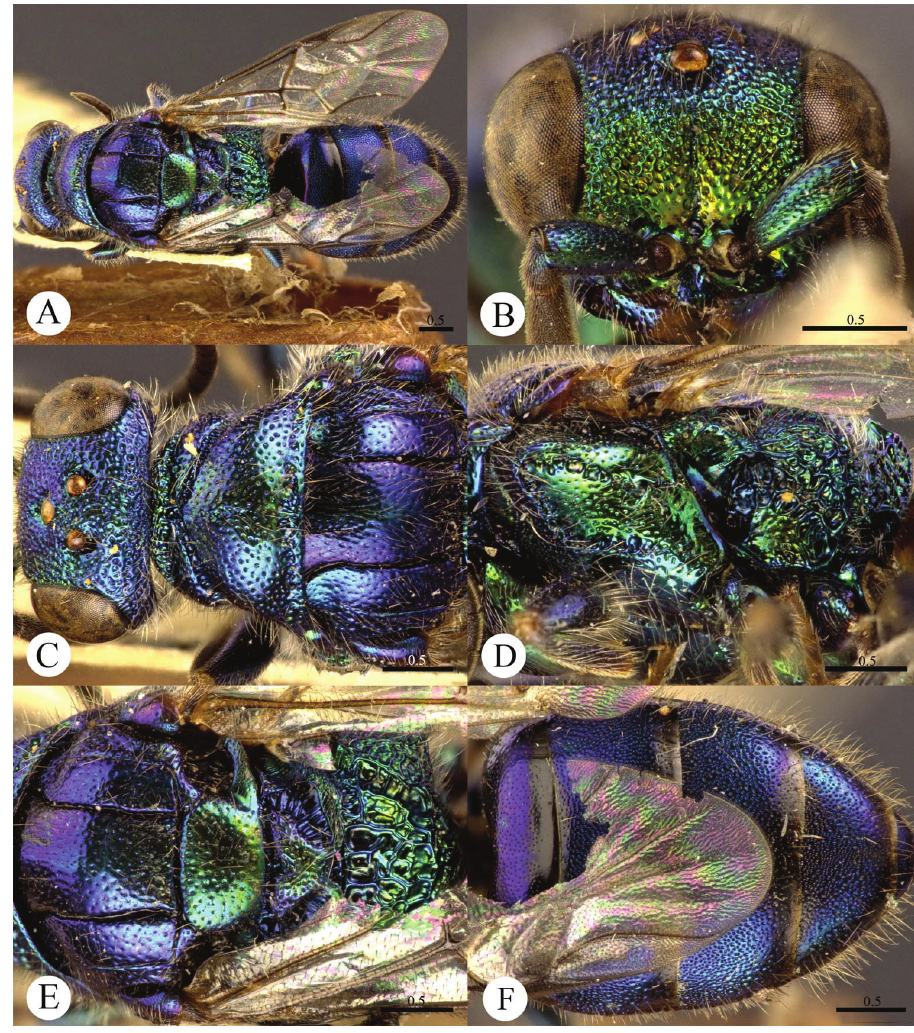
Plate 13. Cleptes sjostedti Hammer, 1950, male from Zhejiang. A Habitus dorsal B Head anterior C Head, pronotum and mesoscutum dorsal D Mesopleuron and metapleuron lateral e Mesoscutum, mesoscutellum, metanotum and propodeum dorsal F Metasoma dorsal. Scale bars in